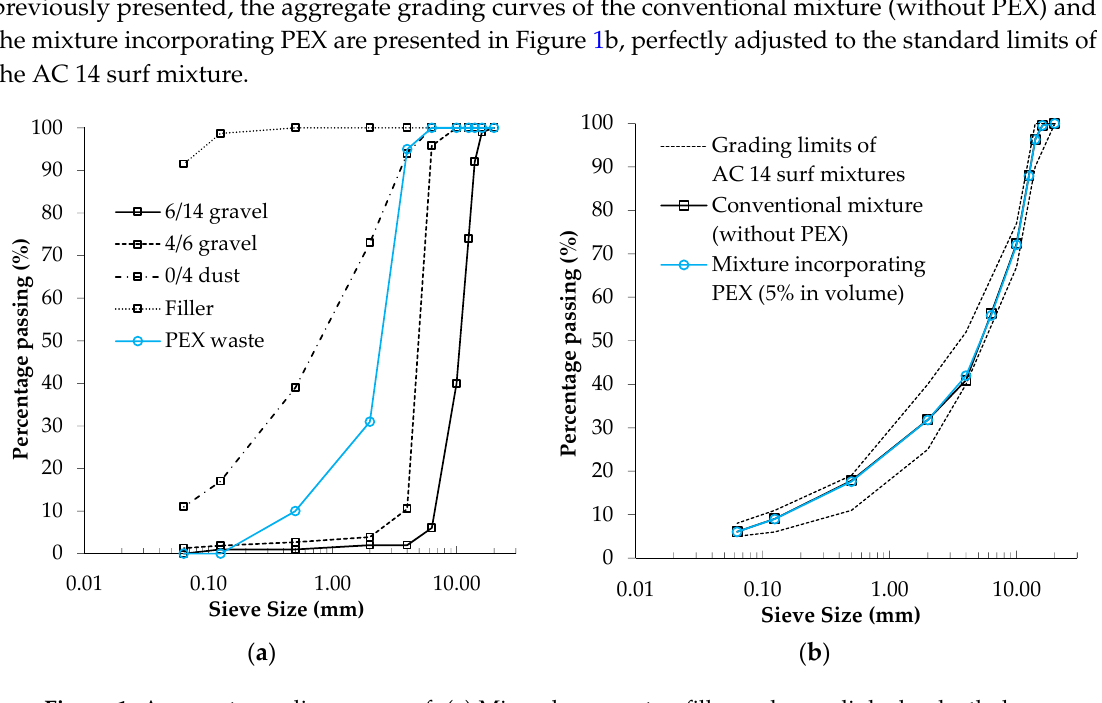
Figure 1. Aggregate grading curves of: ( a ) Mineral aggregates, filler and cross-linked polyethylene (PEX) waste and; ( b ) Asphalt mixtures (with and without PEX) fitted within the limits of an asphalt concrete mixture AC 14 surf.